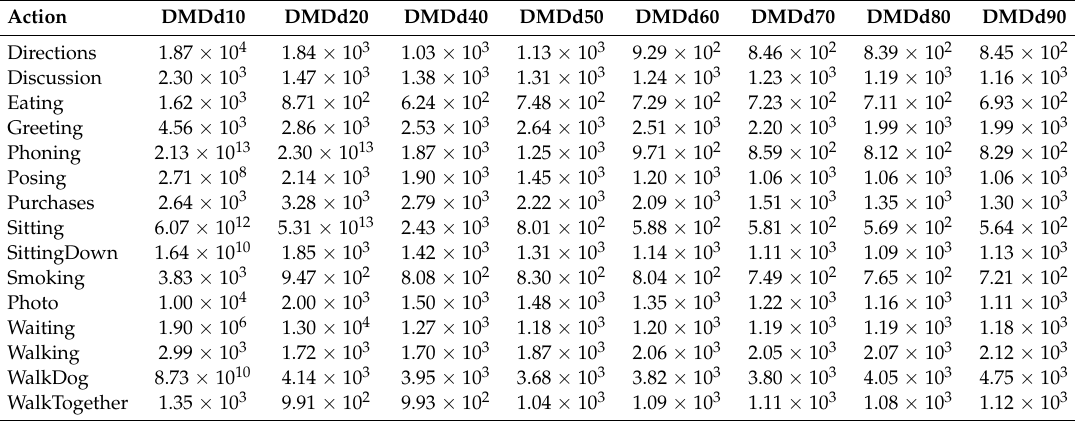
Table 4. Comparison of anticipation errors for 0.4s (20 frames) using Dynamic Mode Decomposition with delays for various numbers of delays (10, 20, 40, 50, 60, 70, 80 and 90). The error measure is the mean squared error on the pose sequences of 2s length on the different motion classes of the Human 3.6M dataset for actor